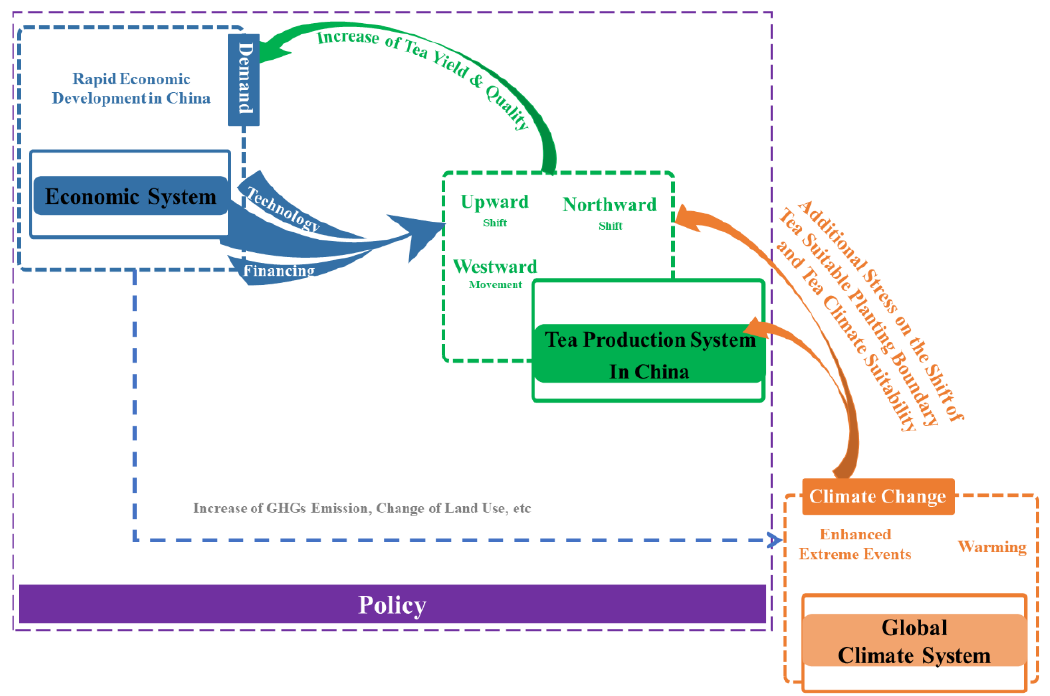
Figure 6. Conceptual adaptation framework on the interaction mechanism amongst Chinese tea production, climate change, and economic development.